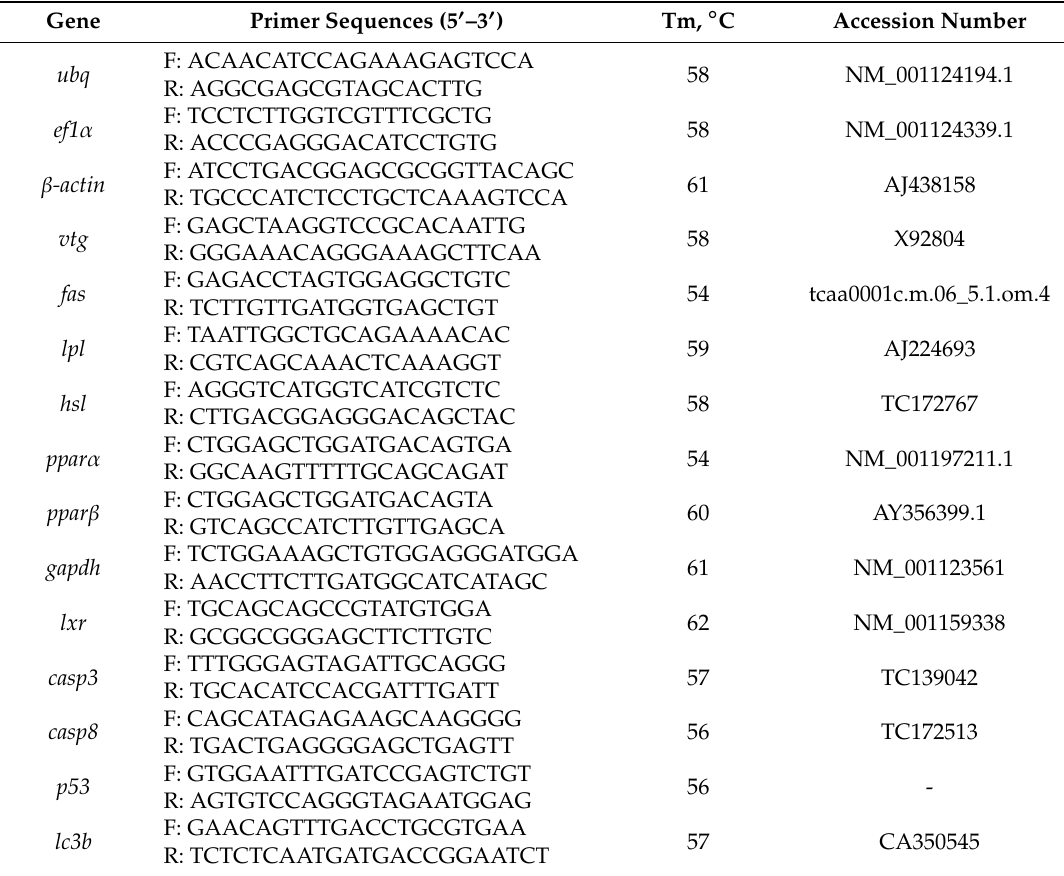
Table 3. Primers used in the real-time quantitative PCR